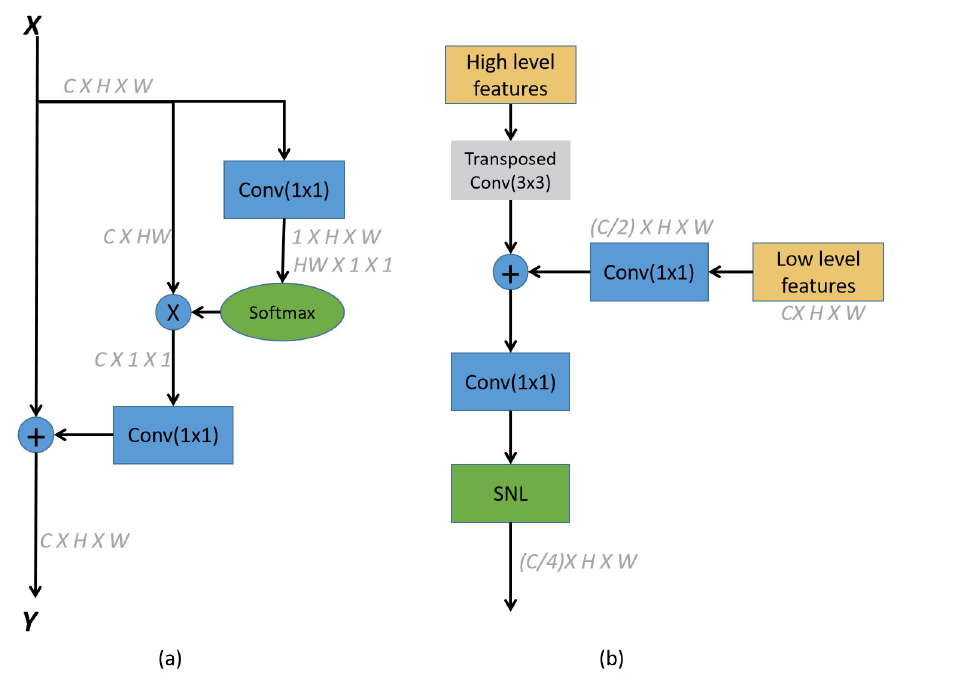
Figure 2. ( a ) SNL block; ( b ) GRM block; C × H × W represents a feature map with channel number C, height H, and width W. Broadcast element-wise addition is denoted by + (cid:13) , and matrix multiplication is denoted by x (cid:13)